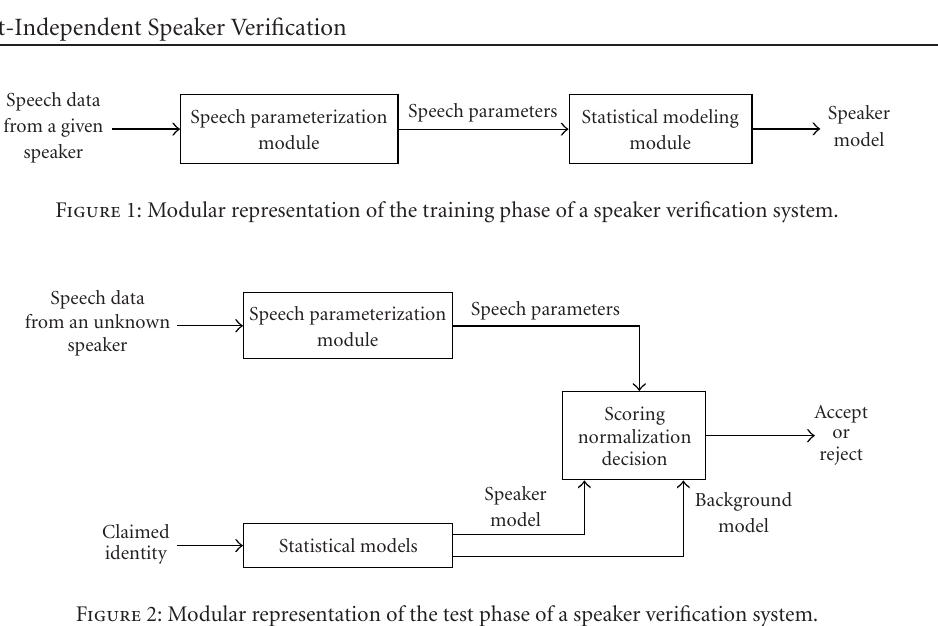
Figure 2: Modular representation of the test phase of a speaker verification